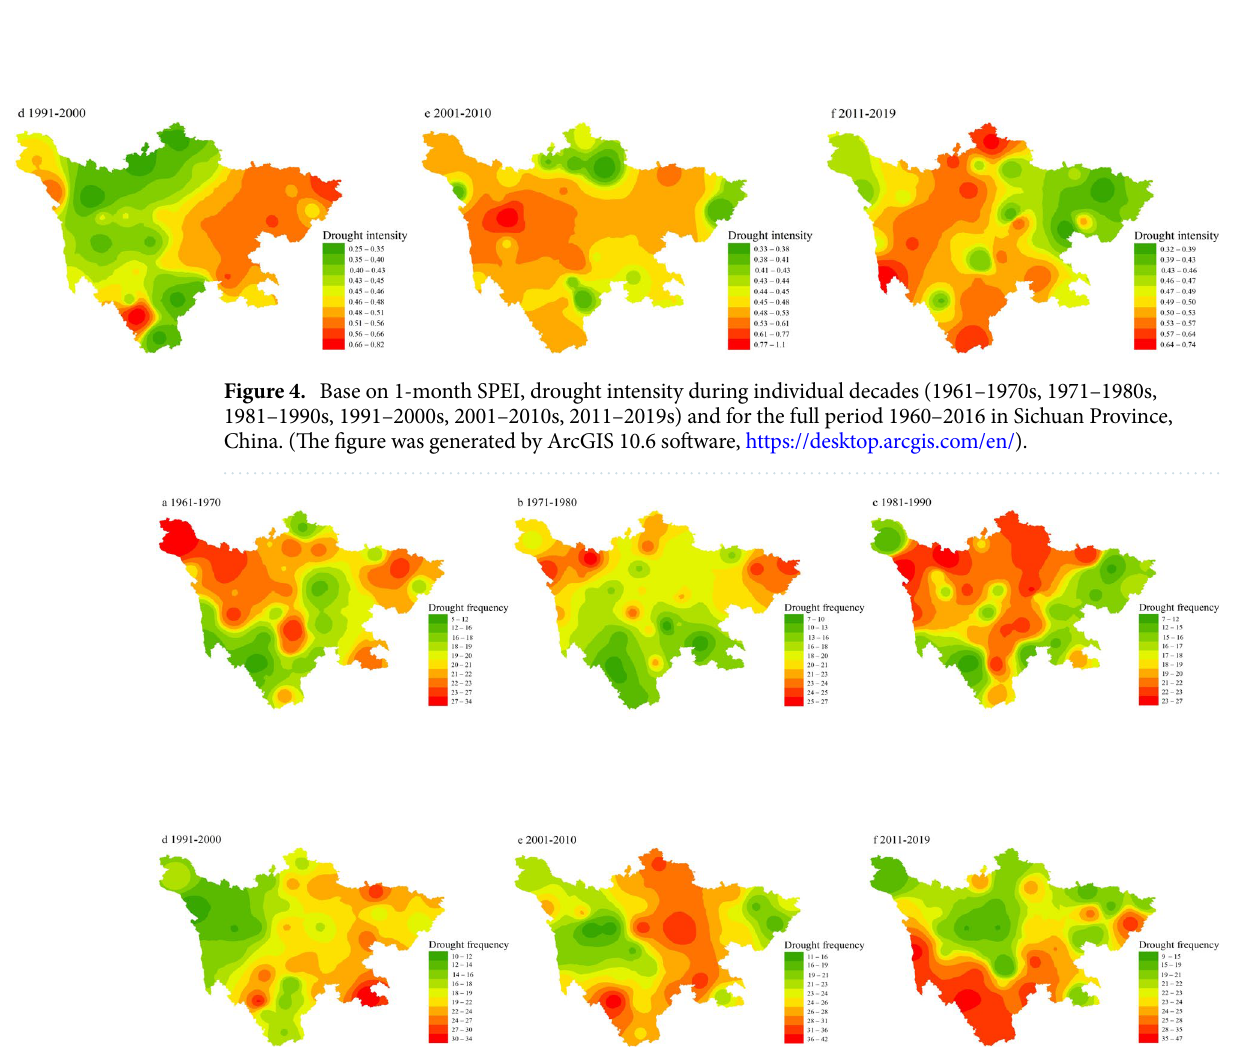
Figure 5. Base on 1-month SPEI, drought frequency during individual decades (1961–1970s, 1971–1980s, 1981–1990s, 1991–2000s, 2001–2010s, 2011–2019s) and for the full period 1960–2016 in Sichuan Province, China. (The figure was generated by ArcGIS 10.6 software, https ://deskt op.arcgi